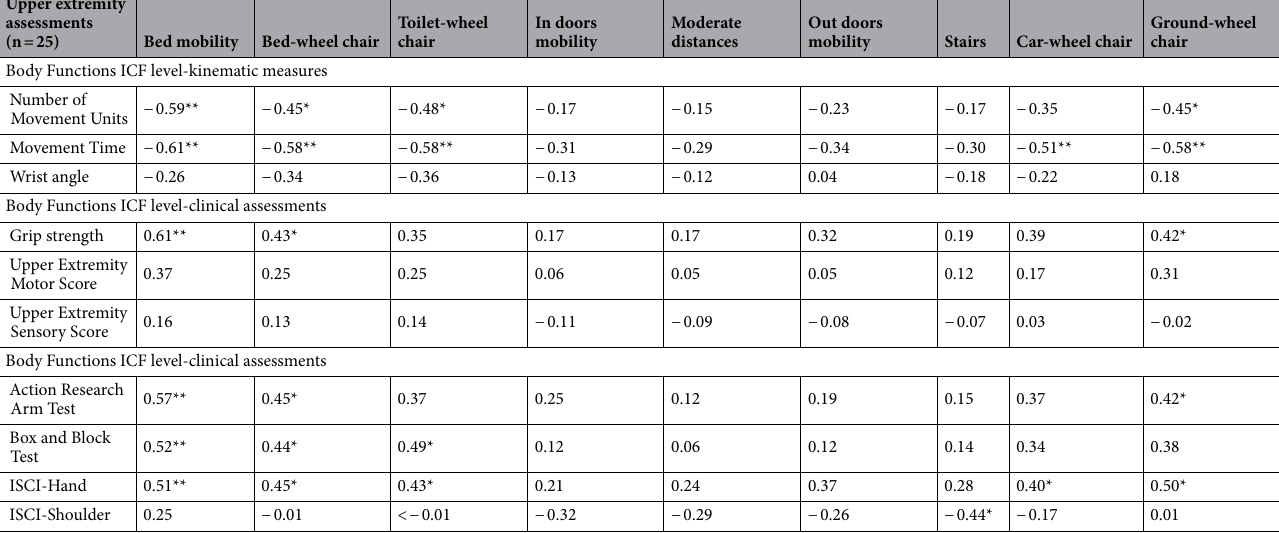
Table 6. Spearman correlation coefficients for each item of the SCIM-mobility subscale and the upper extremity assessments. ** P < 0.01 * P < 0.05 Correlation coefficients > 0.5 are marked with bold. ICF International Classification of Functioning, Disability and Health, ISCI International Spinal Cord Injury Upper Extremity Basic Data Set Form, ISCI-Hand basic Hand variable, ISCI-Shoulder Shoulder variable, SCIM Spinal Cord Independence